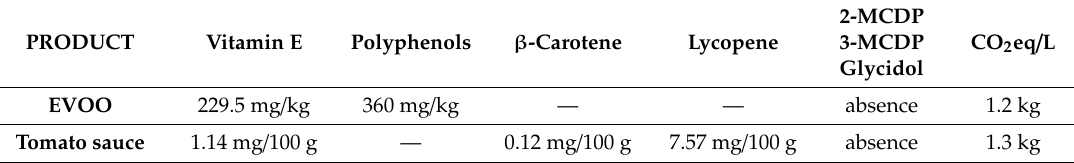
Table 1. SANI products: content of valuable compounds and their carbon